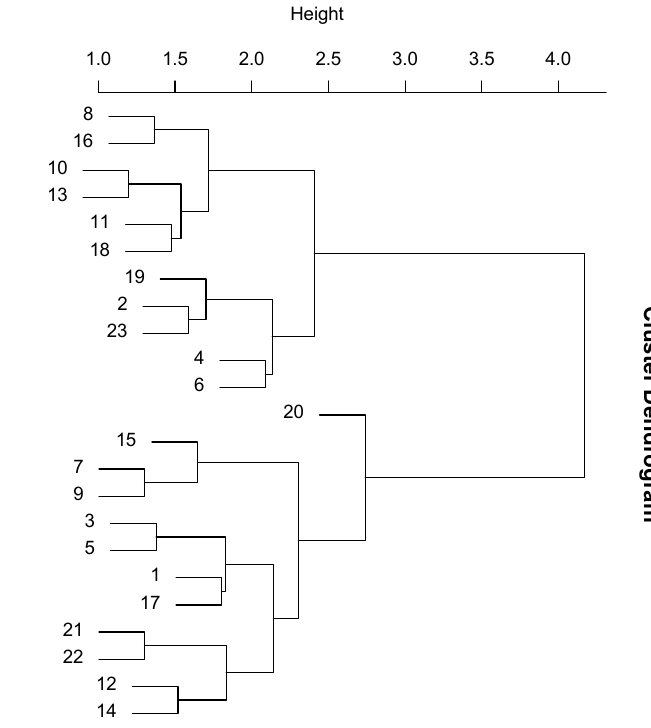
Figure 3. Article cue cluster dendrogram in the low-to-intermediate proficiency group. Table 2. Usage-based categories of article cues in low-to-intermediate proficiency group.